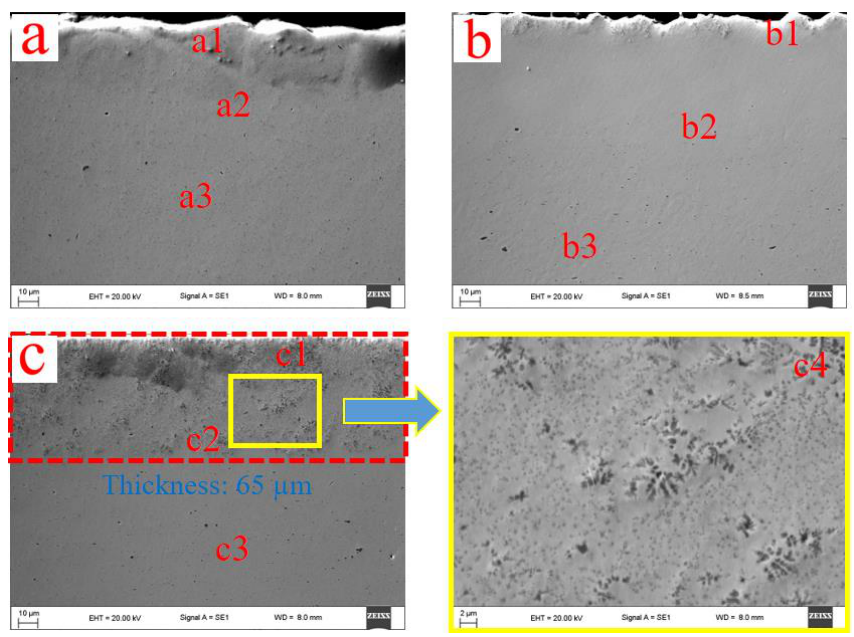
Table 1. The laser parameter for different NiTi samples.